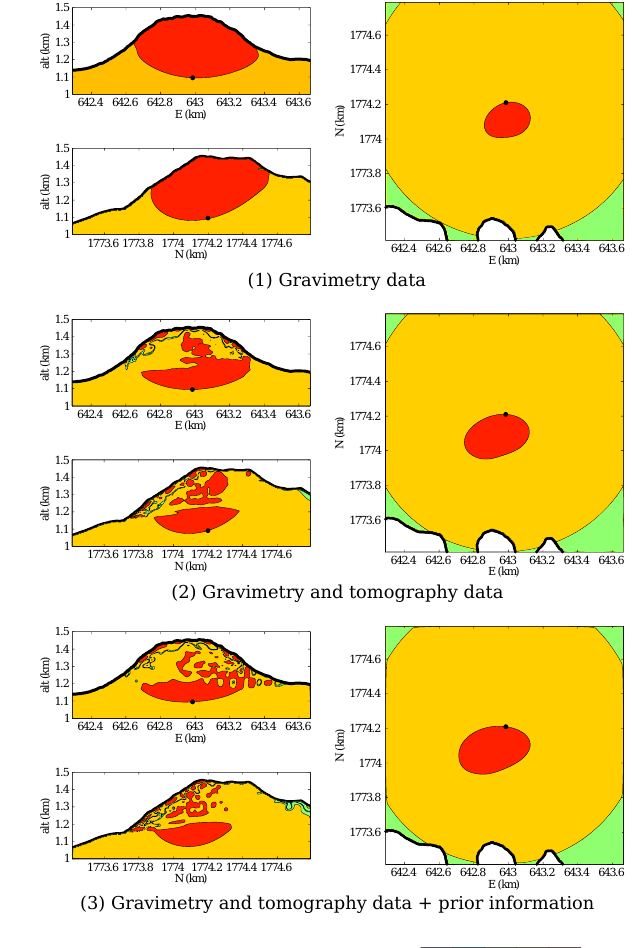
Figure 7. Resolving kernel at point r 2 (Fig. 5): (1) gravity data alone; (2) joined muon radiographies and gravity. (3) is obtained by joining muon radiographies, gravity, and some prior information about the density spatial correlation. See Fig. 1 for the locations of gravity measurements and the three sites for muon